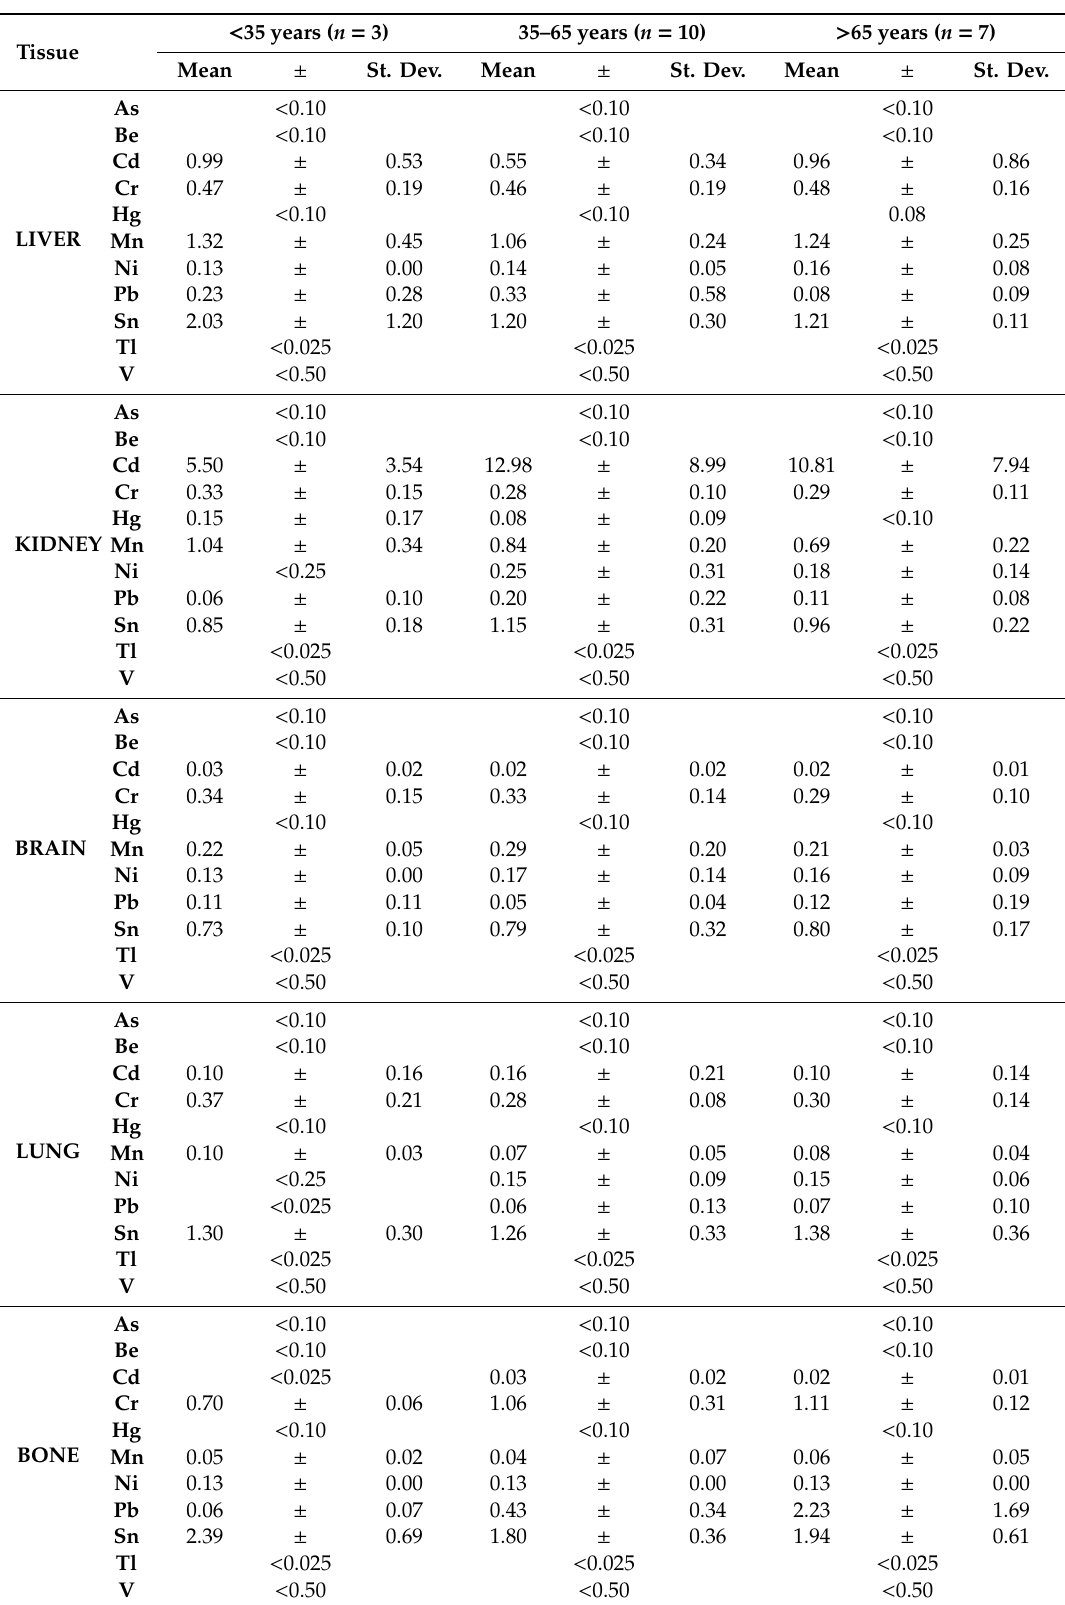
Table 3. Concentrations ( µ g / g) of trace elements in samples of autopsy tissues collected in 2019 according to the age of the